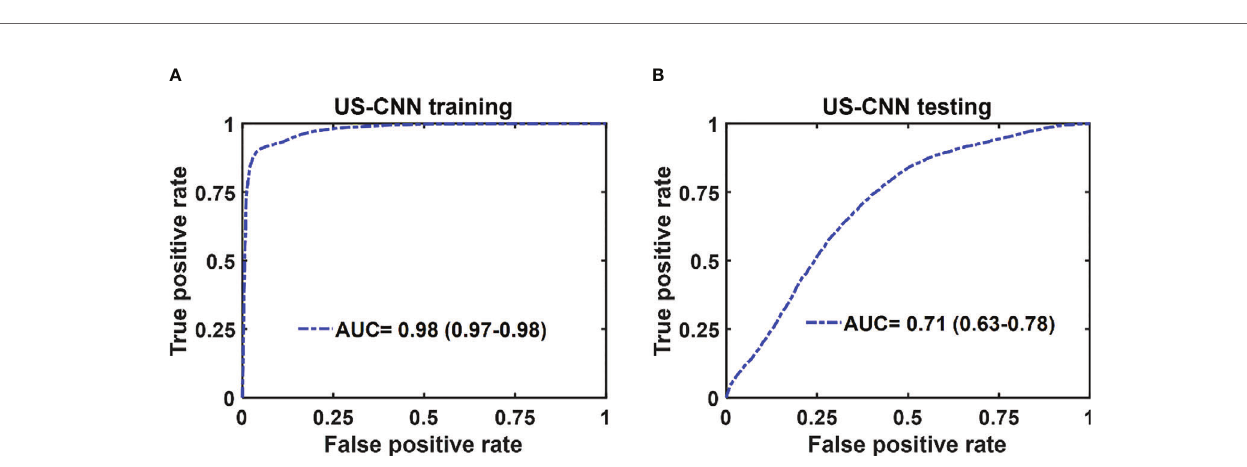
FIGURE 9 | Average ROCs of US-CNN model. (A) training and validation, (B) testing results. The 95% CIs are indicated in